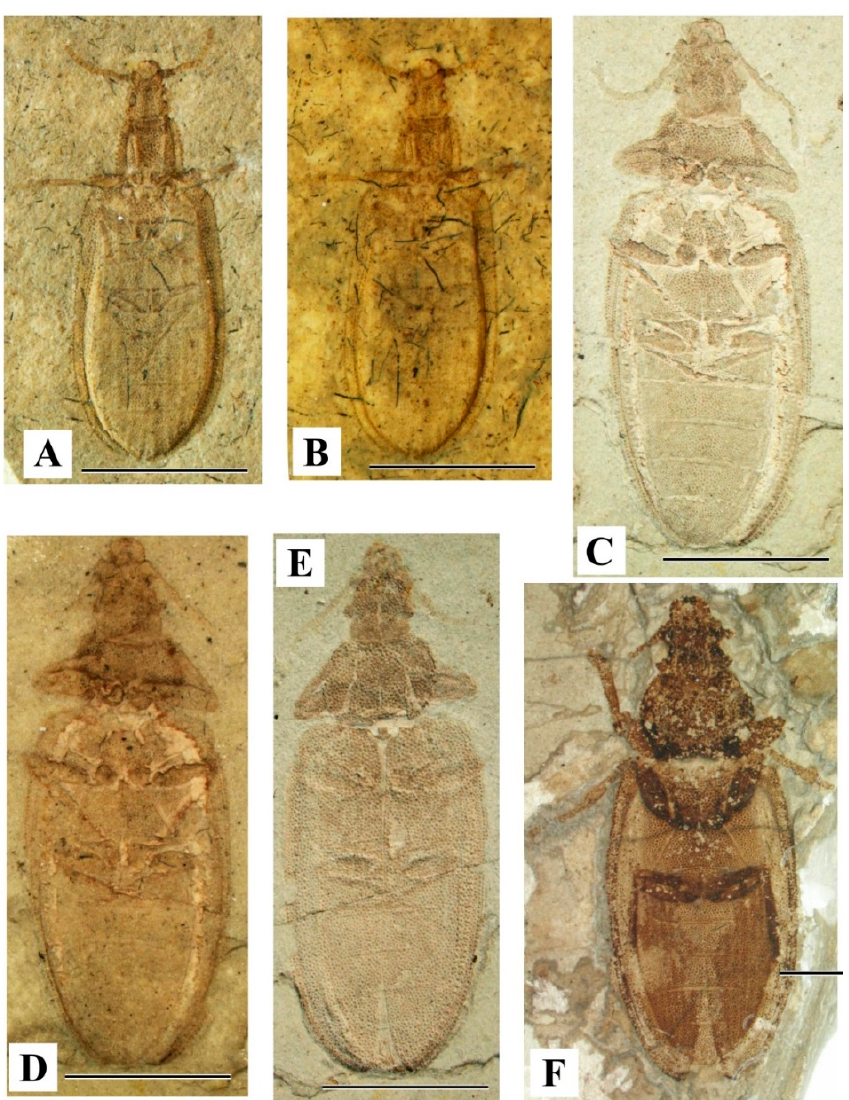
Figure 4. Ommatinae (Cupedidae): A – B — Allophalerus latus comb. nov. [ Tetraphalerus ], holotype CNU -C-LB2006005-1 (Lower Cretaceous, Lower Aptian Liaoning, Chaomidian); A —dry and B —wettened by alcohol: length of print 9.0 mm, scale bar = 3.7 mm; original. C – E — Cionocoleus cervicalis , holotype, part CNU-C-LB2006007-1 and counterpart CNU-C-LB2006007-2 (Lower Cretaceous, Lower Aptian Liaoning, Chaomidian): C —part, dry, D –part, wettened by alcohol, E —counterpart, dry; length of print 24.0 mm, scale bar = 7.0 mm; original. F — Cionocoleus planiusculus , holotype CNU-C-LB2006008 (Lower Cretaceous, Lower Aptian Liaoning, Chaomidian): part, dry; length of print 21.5 mm, scale bar = 7.2 mm; original.